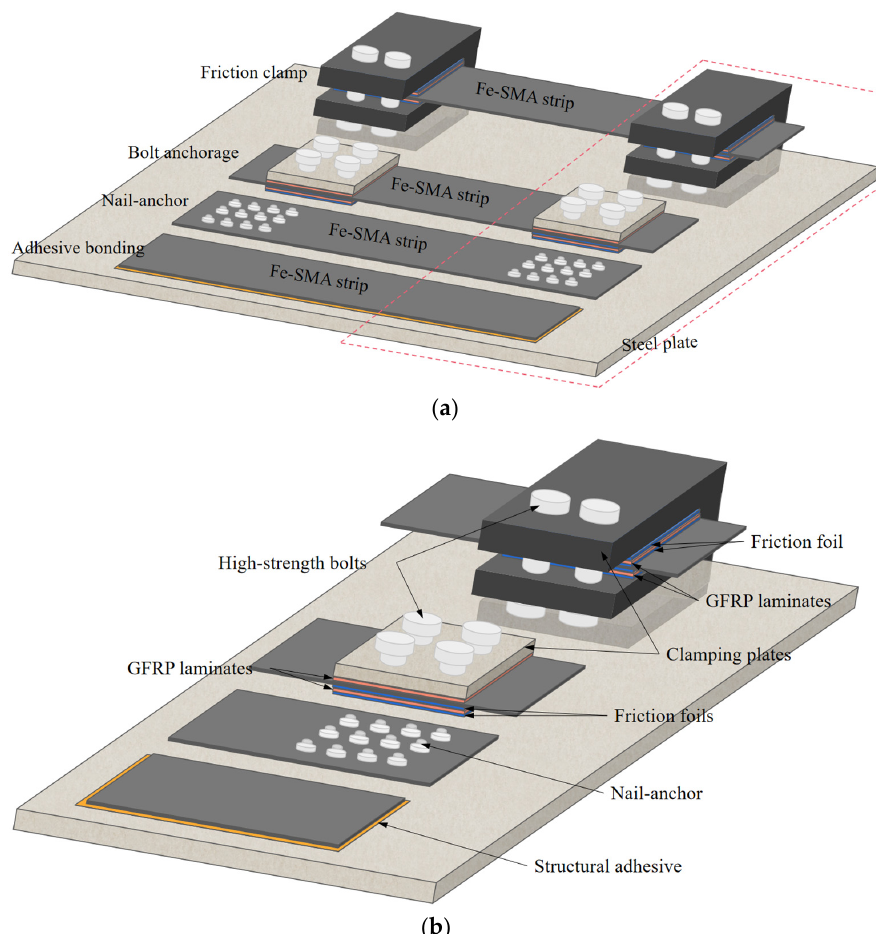
Figure 9. Steel structures reinforced with Fe-SMA and its joining methods: ( a ) reinforcing of steel plates, ( b ) configuration details.